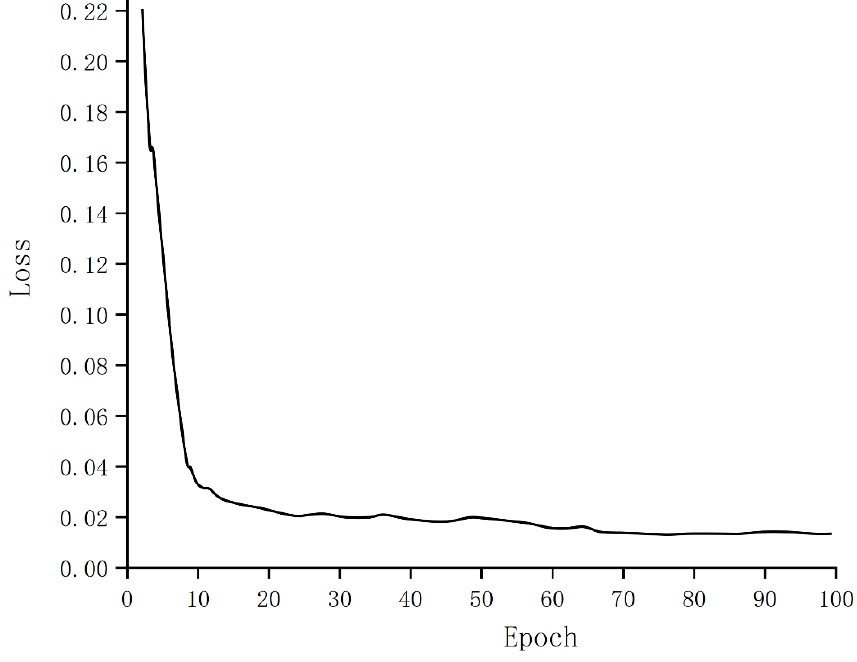
Figure 3. Loss function iteration plot.